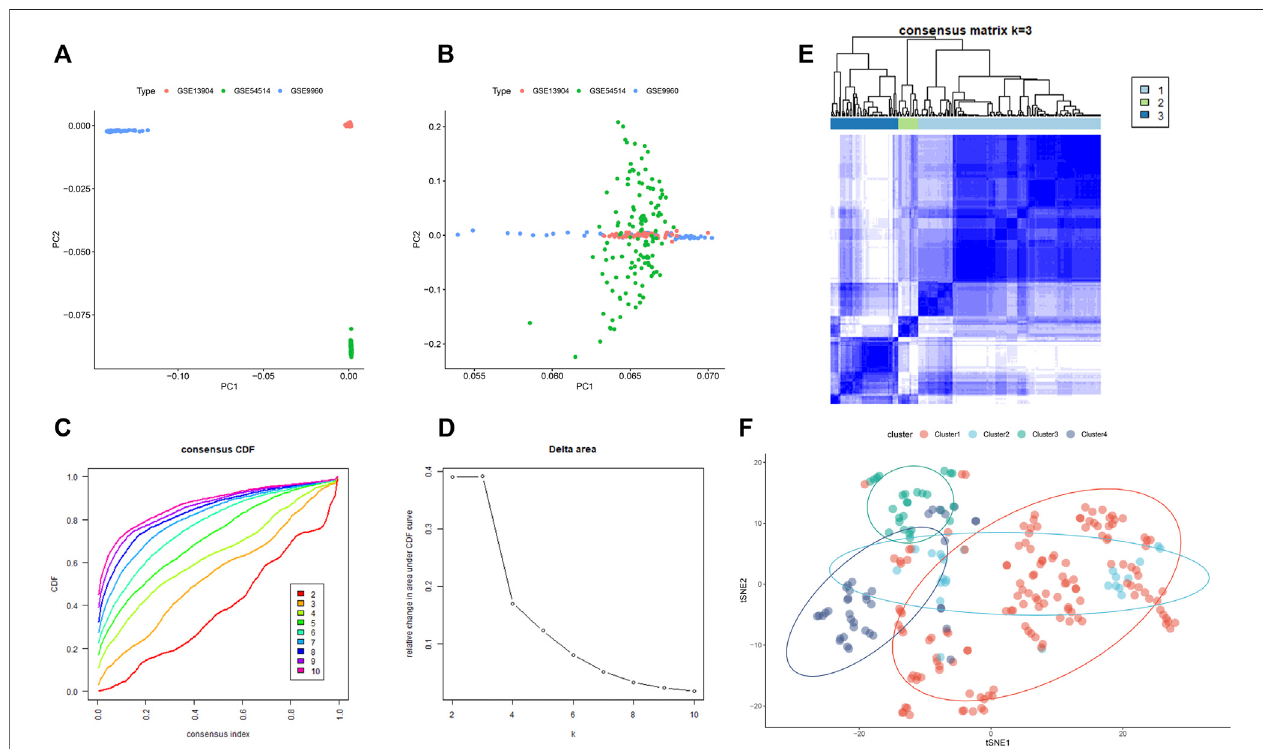
FIGURE 4 | The consensus clustering analysis of sepsis patients. (A) Representative PCA clustering diagram of GSE13904, GSE54514, and GSE9960 datasets before batch correction. (B) Representative PCA clustering diagram of GSE13904, GSE54514, and GSE9960 datasets after batch correction. (C) Cumulative distributionfunction(CDF)curvesofclustering(k,2 – 10). (D) TheCDFDeltaareacurveofallsepsissampleswhenk=2 – 10. (E) Consistencymatrixofthesamplewithk= 3. (F) t-SNE con fi rmed the classi fi cation of three clusters: Cluster1, Cluster3, and Cluster4.